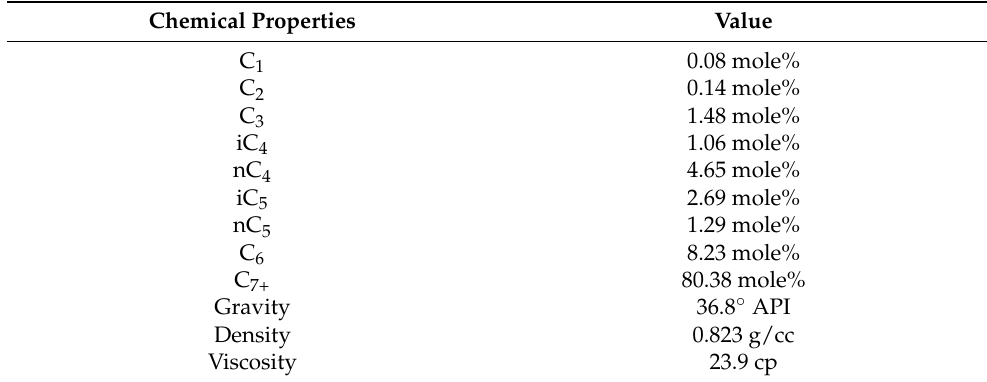
Table 3. The oil properties and composition at 14.7 psi and 60 ◦ F.